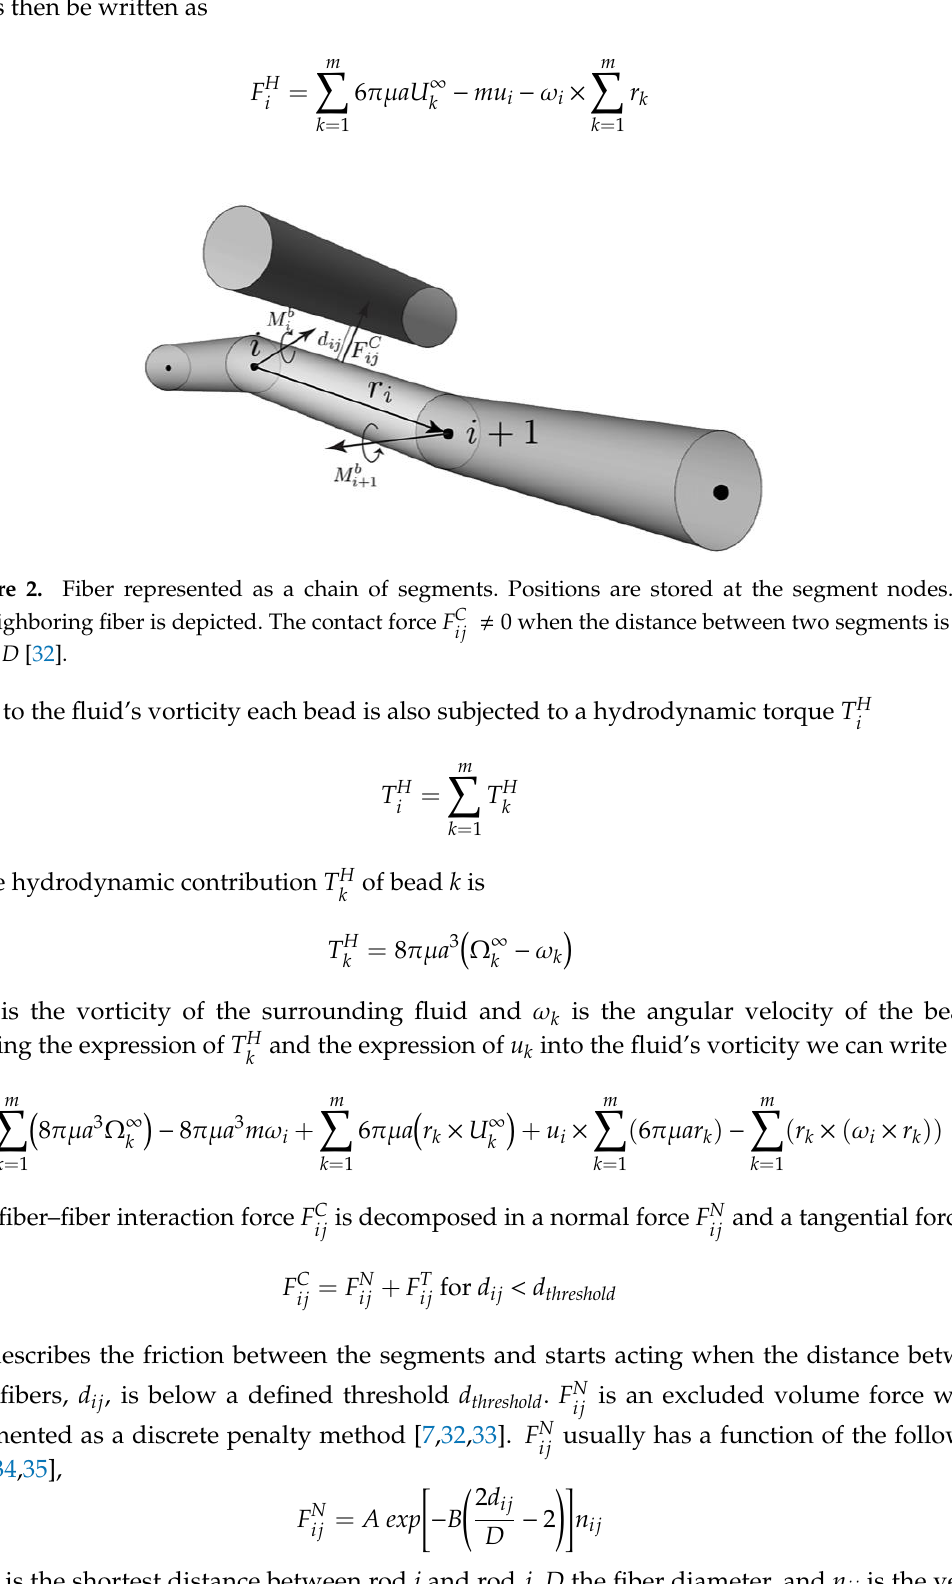
3 of 17 Figure 1. Particle-level simulation: modeling single fiber and macroscale interactions [7]. In the model, inertial effects are neglected due to the low Reynolds numbers (Re) that result from the high viscosity of the polymer matrix. It has been shown experimentally by Hoffman [28] and Barnes [29] that inertial effects become important at Re ≥ 10 − 3 . In our work, the Re was calculated to be in a range of 10 − 9 – 10 − 4 . Long-range hydrodynamic interactions are neglected as well due to the fluid’s high viscosity [30]. Additionally, extensional and torsional deformations are neglected as fluid forces are not sufficiently high to cause fiber stretching or torsional deformation. Only bending deformation is included in the model. Brownian motion can be neglected as the Peclet number (Pe) is well above 10 3 and at this point Brownian interactions are disrupted by hydrodynamic forces [31]. Buoyant effects are neglected in the model as well [7,32]. The presence of fillers in any suspension modifies the flow field, especially in the semi-diluted and more concentrated regimes. However, the coupling between particle and fluid is not considered in the present formulation due to its high computational cost [32]. The force calculation for a segment 𝑖 includes the drag force 𝐹 𝑖𝐻 , the interaction force with an adjacent segment 𝑗 𝐹 𝑖𝑗𝐶 , and intra-fiber forces 𝑋 𝑖 exerted by internal connection loads at the nodes. The translation equation of motion is